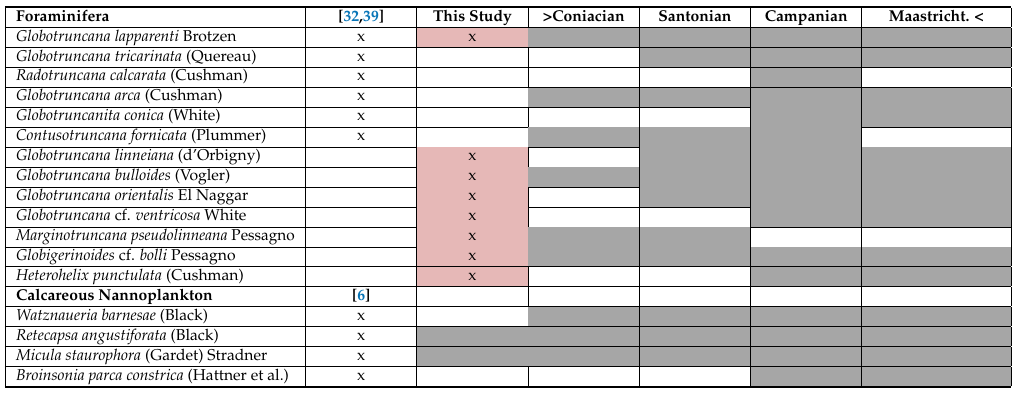
Table 2. Stratigraphic span of planktic foraminifera found in the Scaglia Limestones from the southwestern and southern part of the Medvednica Mt. ([32,39], this study) and calcareous nannoplankton found at Mikuli´c Potok Creek [6]. Fossil names from previous studies revised according to [34–36]. Presence of fossils marked by x and their stratigraphic span by grey stripes. Fossils determined during this study highlighted by pink background.